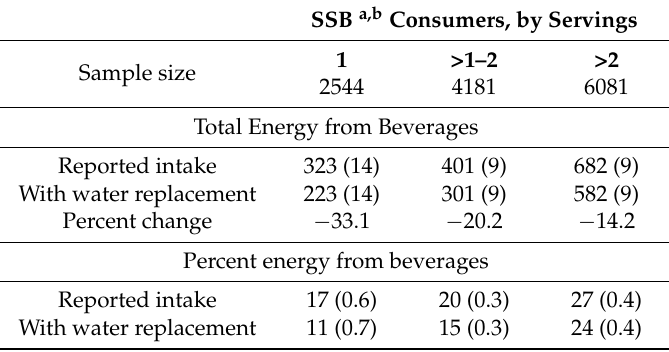
Table 3. Impact on total energy and percent of energy from beverages resulting from one replacing one serving SSB with one serving of water among adults (aged 19+), NHANES 2007–2012.